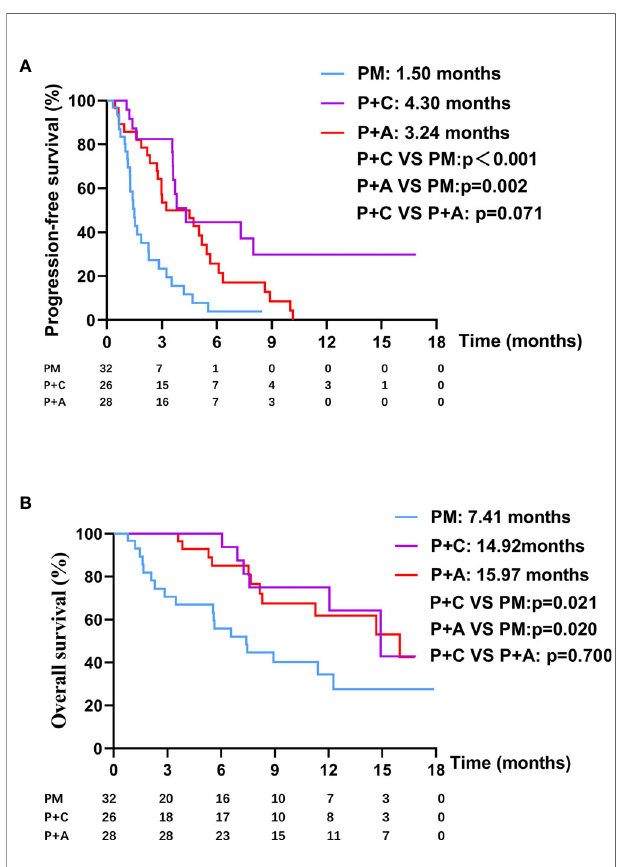
FIGURE 2 | (A) The PFS curve of patients in PM, P+C and P+A groups. (B) The OS curve of patients in PM, P+C and P+A